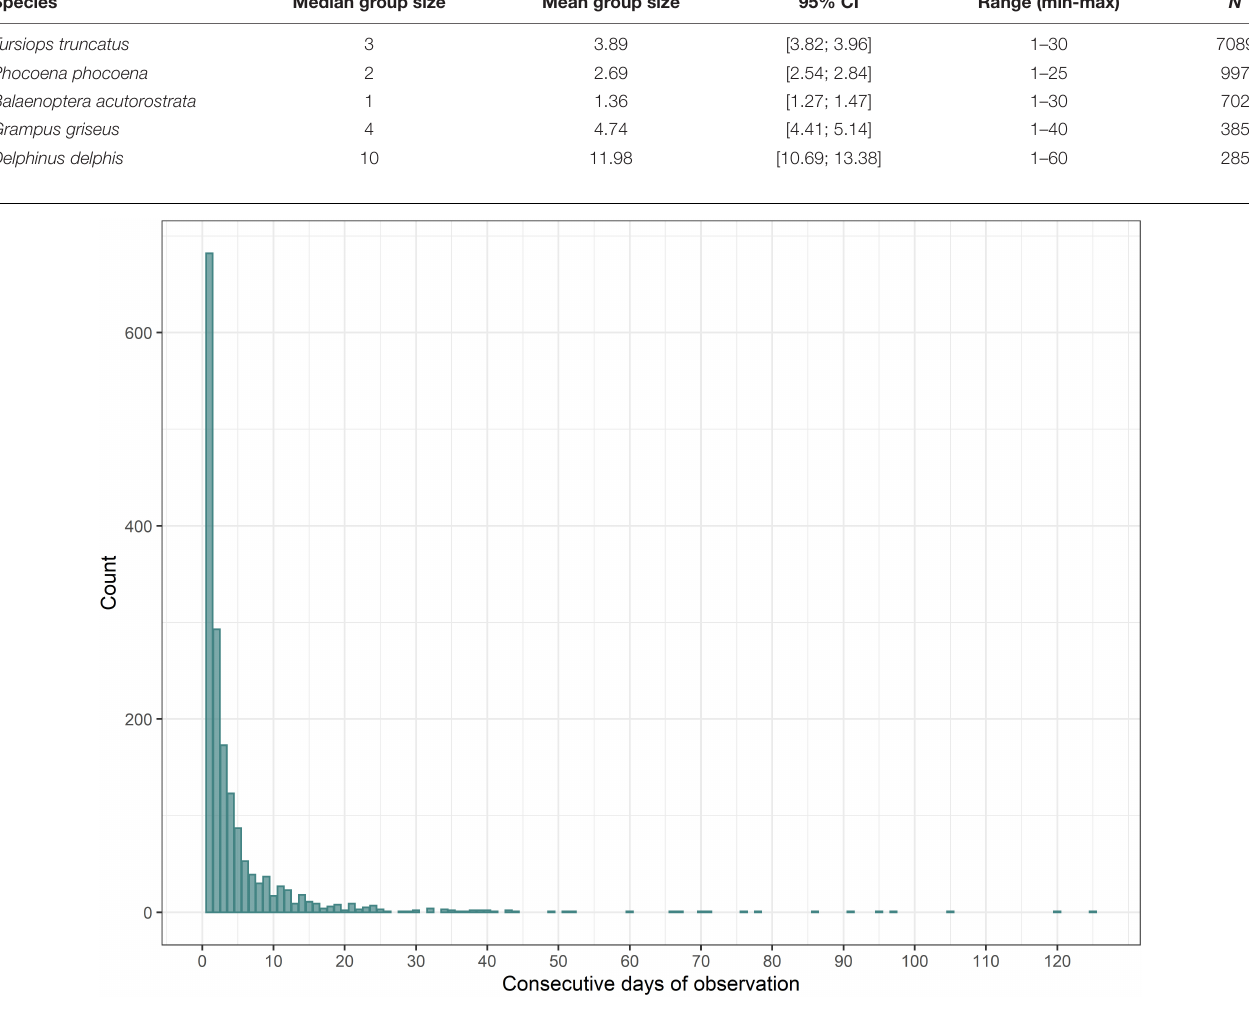
carrying out 5 or more successive watches, the absolute values of variance obtained should be treated with caution since there is autocorrelation in the